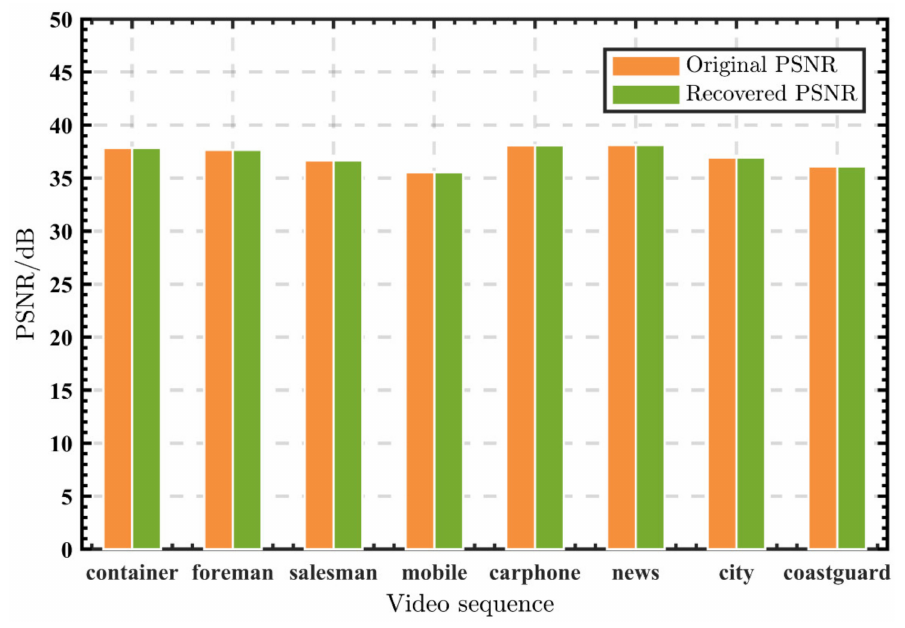
Figure 12. PSNR comparison.